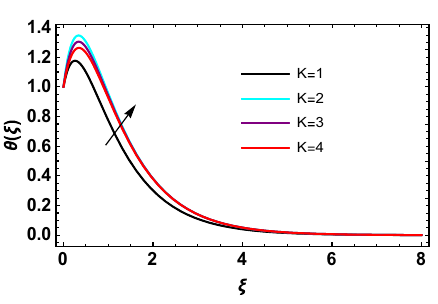
Figure 12. Impact of K on θ(ξ) .